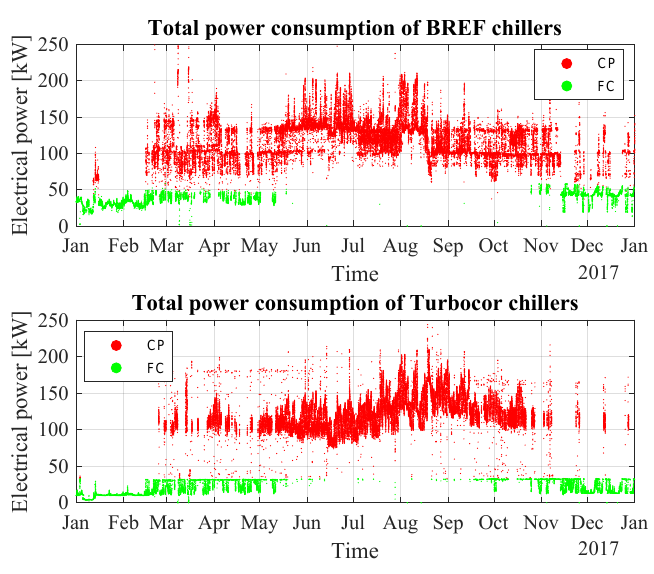
Figure 9. Cooling capacities.